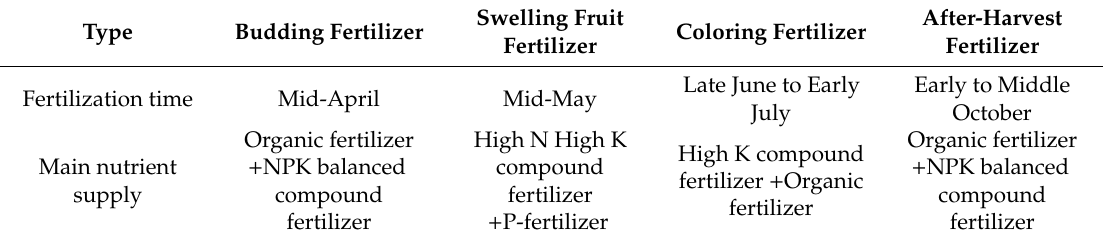
Table 4. Recommended fertilization time and main nutrient